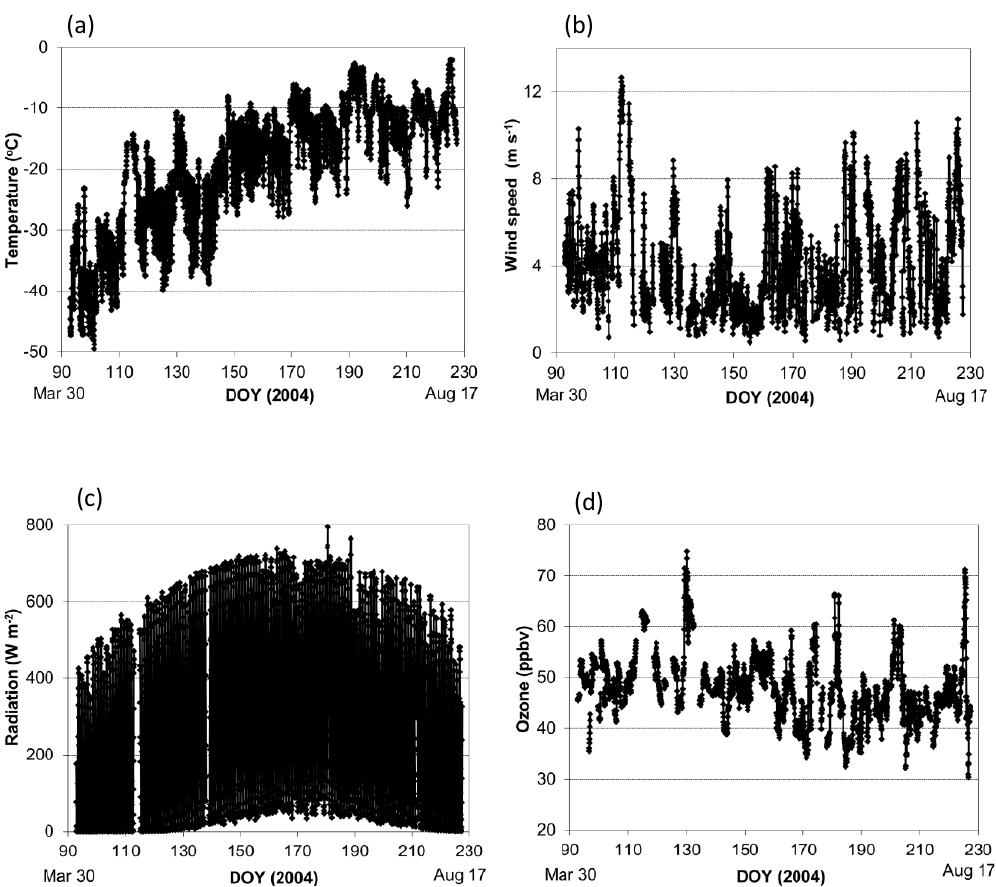
Fig. 2. Hourly averaged time series (DOY 92–227 [1 April–14 August 2004]) data for air temperature ( ◦ C) (a) , wind speed (ms − 2 ) (b) , solar radiation (Wm − 2 ) (c) , and ozone mixing ratio (ppbv) (d) , each measured at